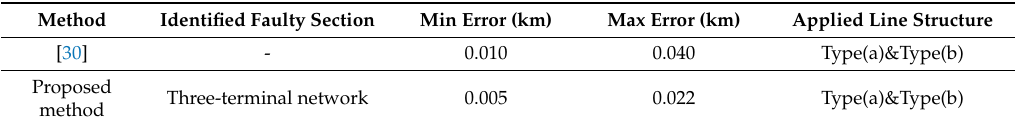
Table 9. Comparison with the existing methods in [30].